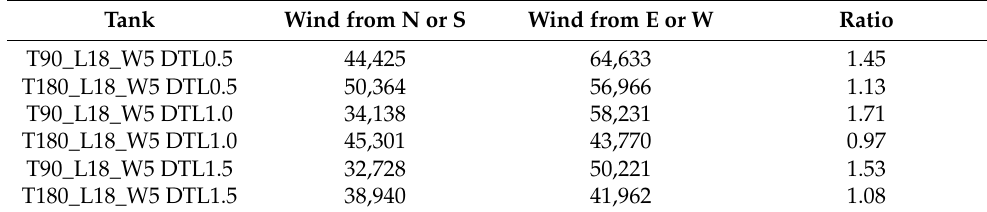
Table 6. Average OER (ouE/s) calculated for different wind directions. Tank Wind from N or